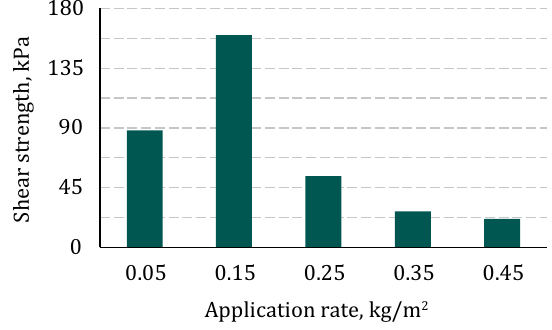
Figure 7. Interfacial shear strength versus tack coat application rate for Precast Rubber Asphalt